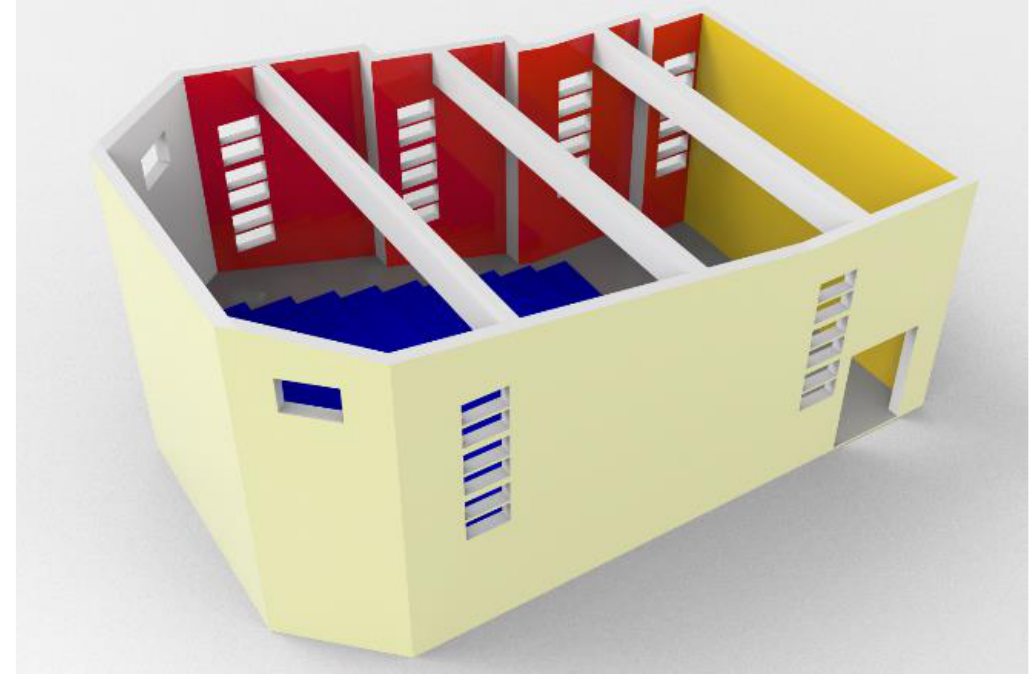
Figure 3. Geometry isometric view (side)